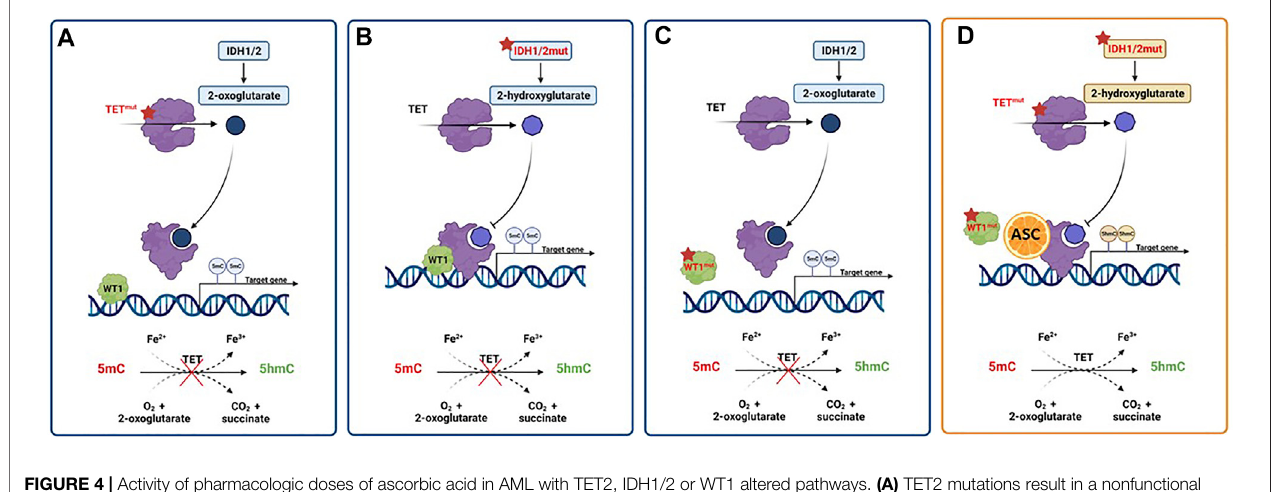
FIGURE 4 | Activity of pharmacologic doses of ascorbic acid in AML with TET2, IDH1/2 or WT1 altered pathways. (A) TET2 mutations result in a nonfunctional enzymewithhypermethylationofgenepromoters,and preventionofoxidation of5-methylcytosine(5mC)to5-hydroxymethylcytosine(5hmc). (B) The presenceofgain- of-function mutations in IDH1/2 genes results in the overproduction of the oncometabolite 2-hydroxyglutarate (2-HG) with the inhibition of TET2 activity. (C) WT1 mutations hamper the ability of TET2 to bind and activate WT1, inhibiting the expression of WT1-target genes. (D) Ascorbic acid treatment mimics TET2 restoration, inducing a reversal of defective DNA methylation and cell differentiation, ultimately inhibiting tumor progression. Created with Biorender.com.